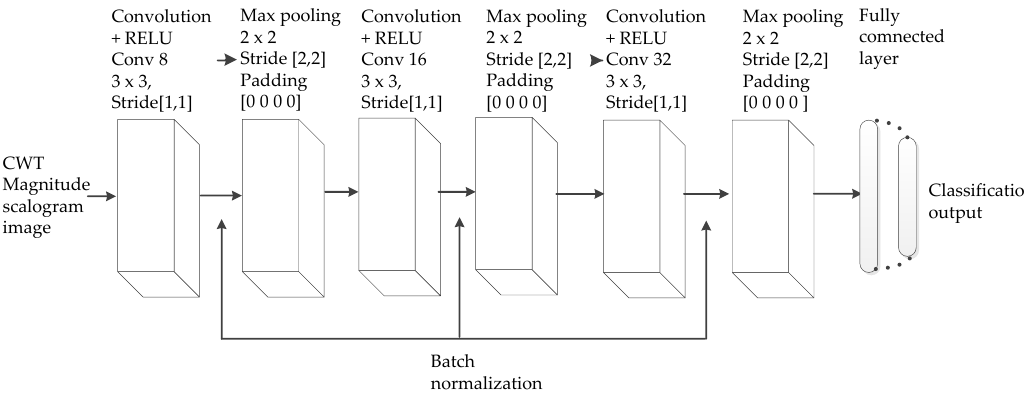
Figure 2. The general structure of the convolutional neural network considered.